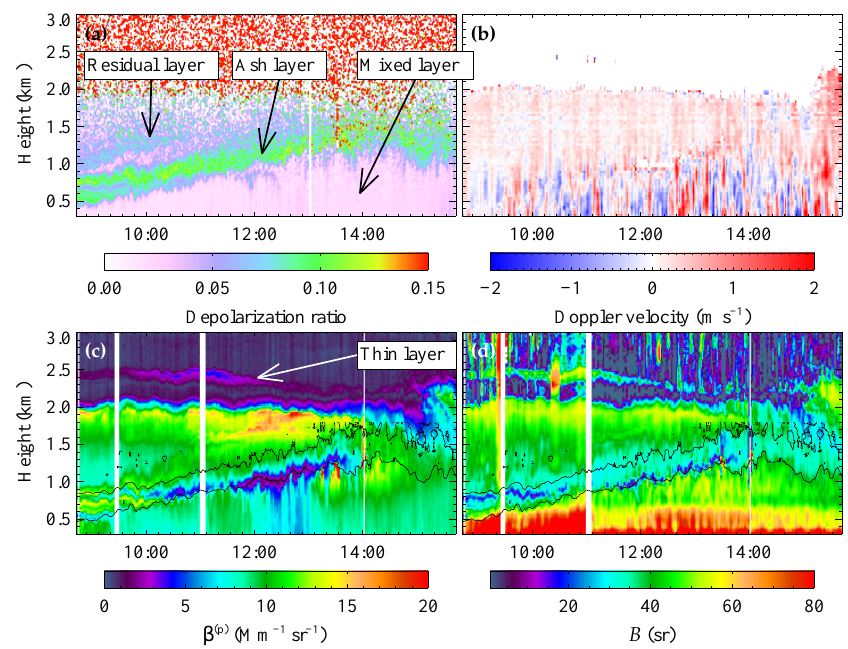
Fig. 17. Observations of the Eyjafjallajökull ash plume at CFARR on 19 April 2010. (a) Volume depolarisation ratio observed by the EZ lidar. Values above 1.9km are dominated by noise. (b) Vertical velocity observed by a Halo Doppler lidar. (c) Backscatter retrieved (in the linear mode) from analogue CUV measurements. The 0.07 isoline of volume depolarisation below 1.8km is shown to highlight the ash layer. (d) Lidar ratio retrieved from same.